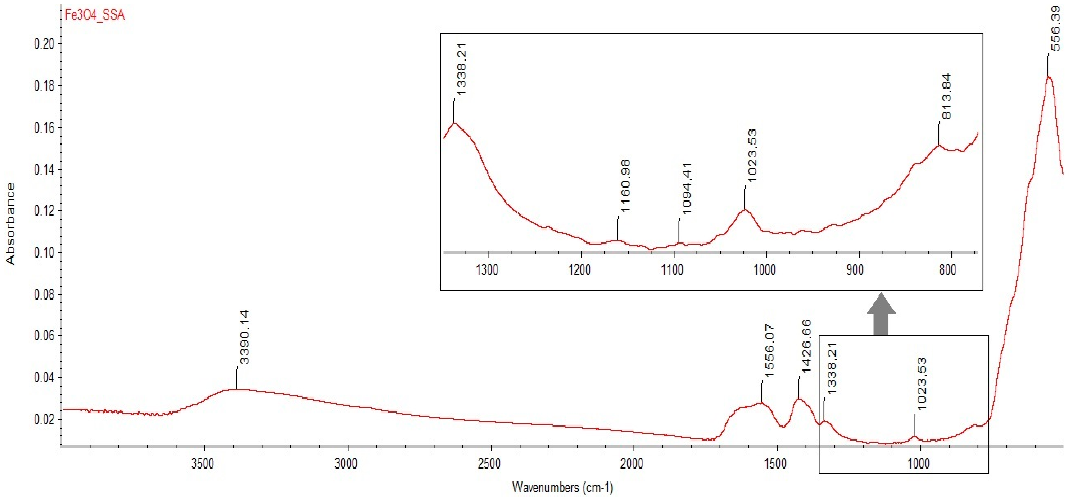
Figure 2. The measured Fourier transform infrared spectroscopy (FT-IR) spectrum of the Fe 3 O 4 –SSA nanoparticles for wavenumbers from 4000 to 500 cm − 1 . The inset provides a detailed overview of wavenumbers between 1338.21 and 813.84 cm − 1 .